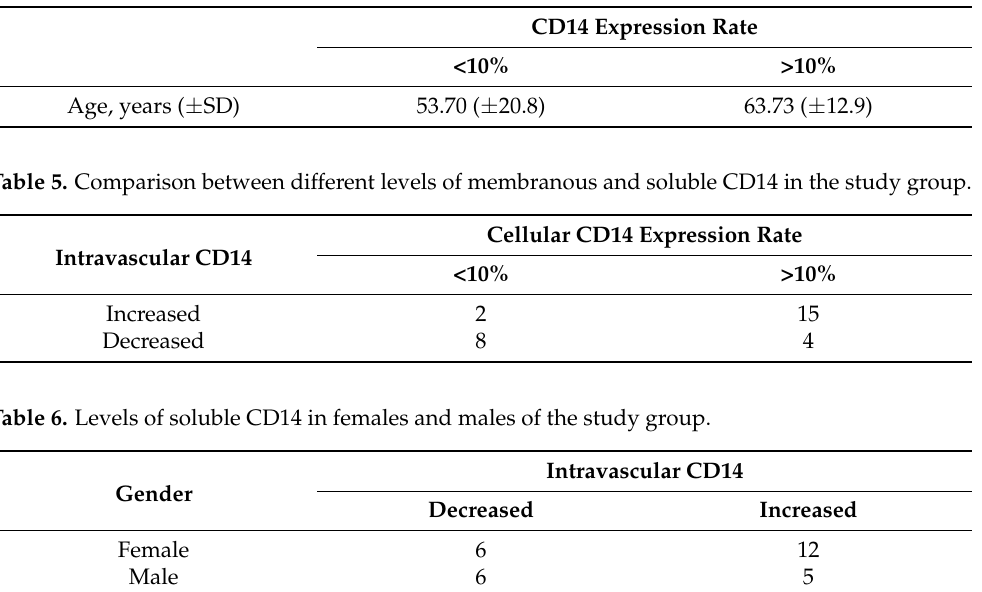
Table 4. Age distribution according to CD14 expression in the study group.